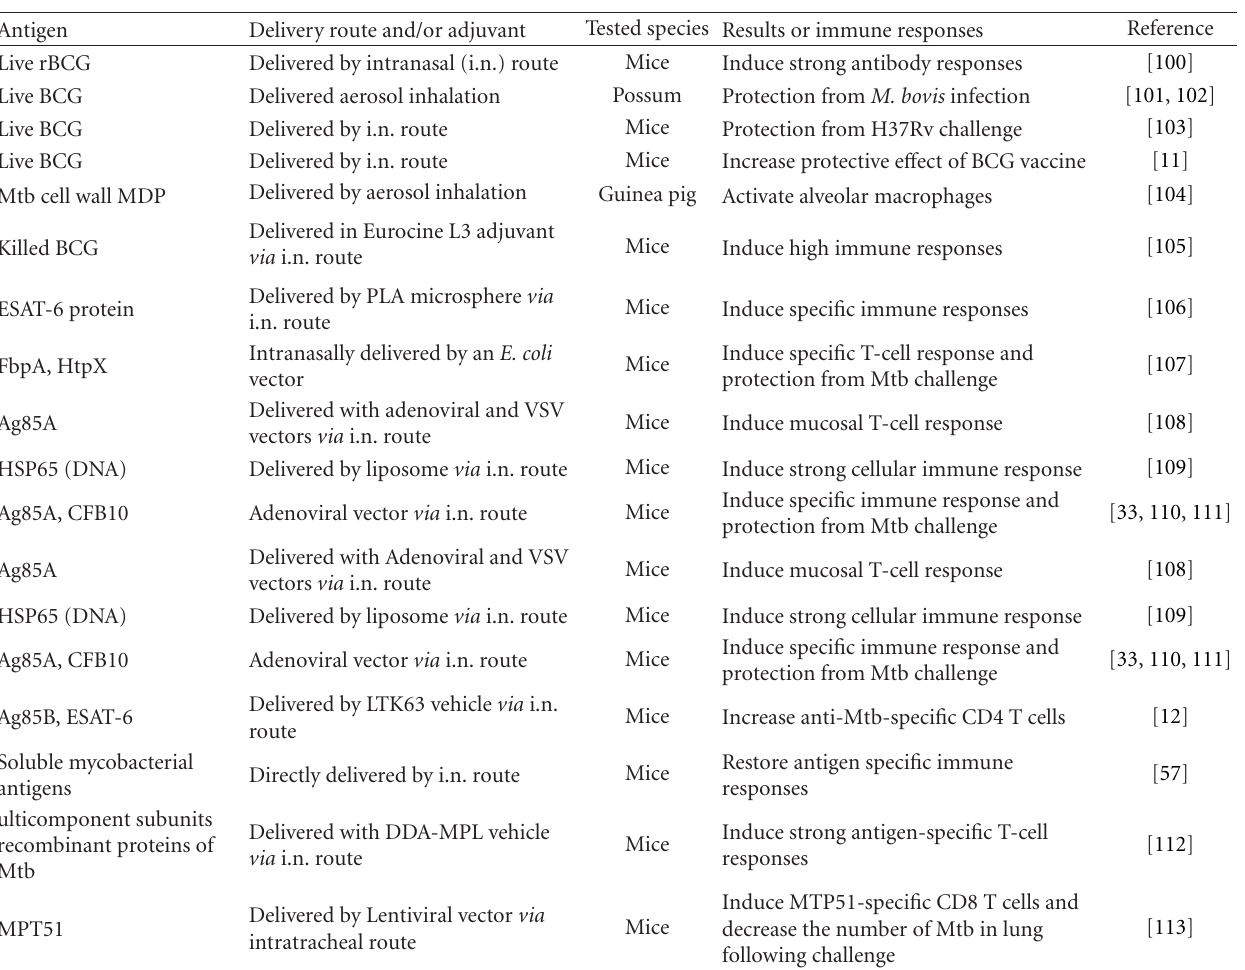
Table 1: Respiratory delivery of vaccine candidates against mycobacteria infection +